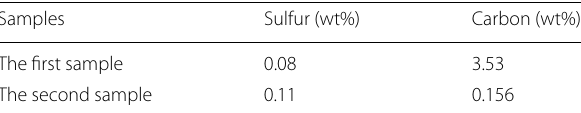
Table 1 Results of carbon/sulfur analysis of the iron samples